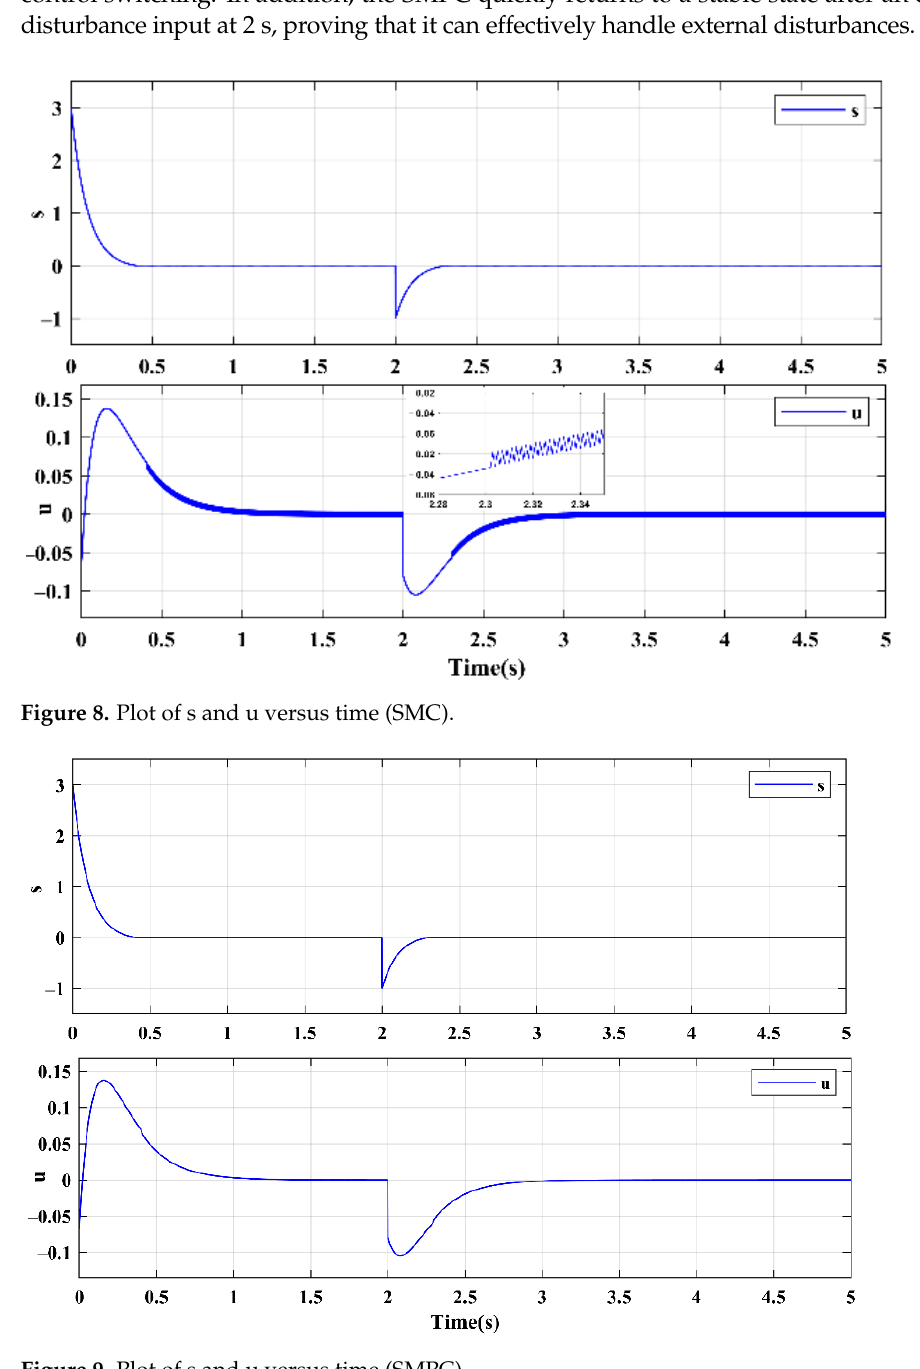
Figure 9. Plot of s and u versus time (SMPC).